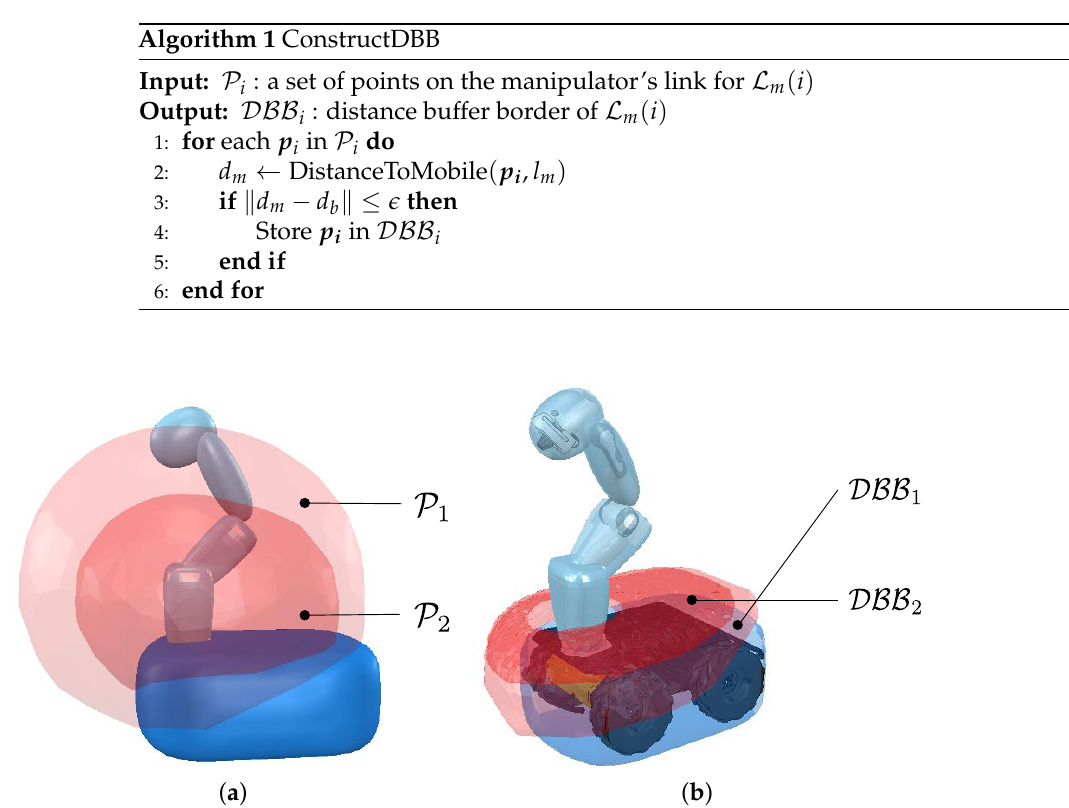
Figure 3. Visualization of P i and DBB i for L m ( i ) . ( a ) Red volume represents P i which is a point set around the mobile robot; ( b ) red hyperplanes represent the distance buffer borders of L m . The buffer distance d b is set to 0.15 m and the tolerance (cid:101) is set to 0.01